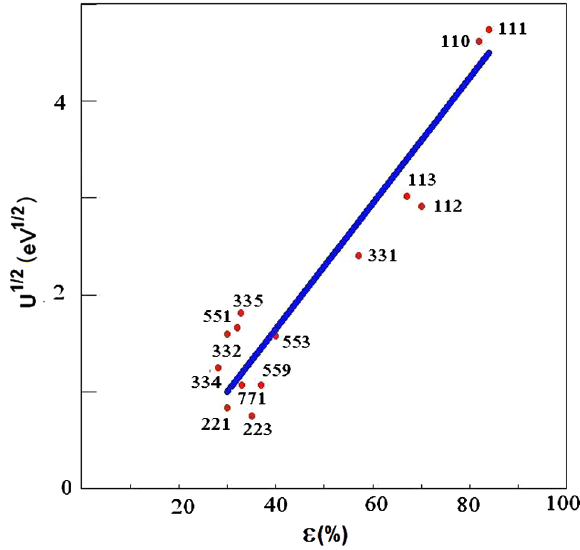
FIG. 10. Linear approximation of the experimental data.